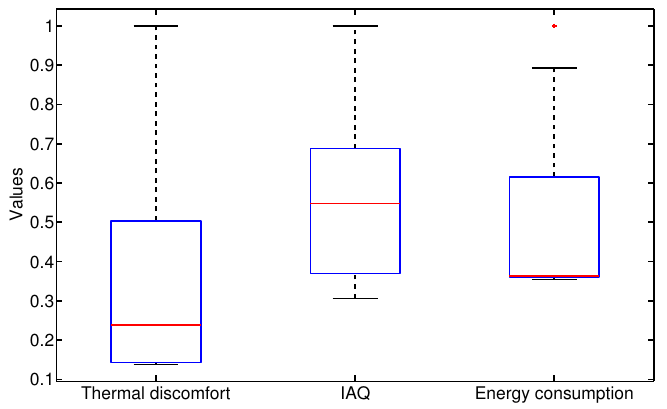
Figure 11. Boxplot of the three indexes achieved by the 23 best solutions on the 3D Pareto front. Finally, one of the best 23 solutions is chosen from the 3D Pareto front for full simulation.